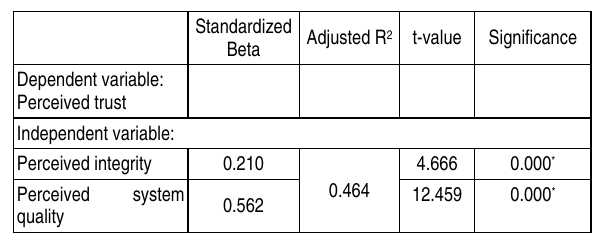
Table 4. Regression